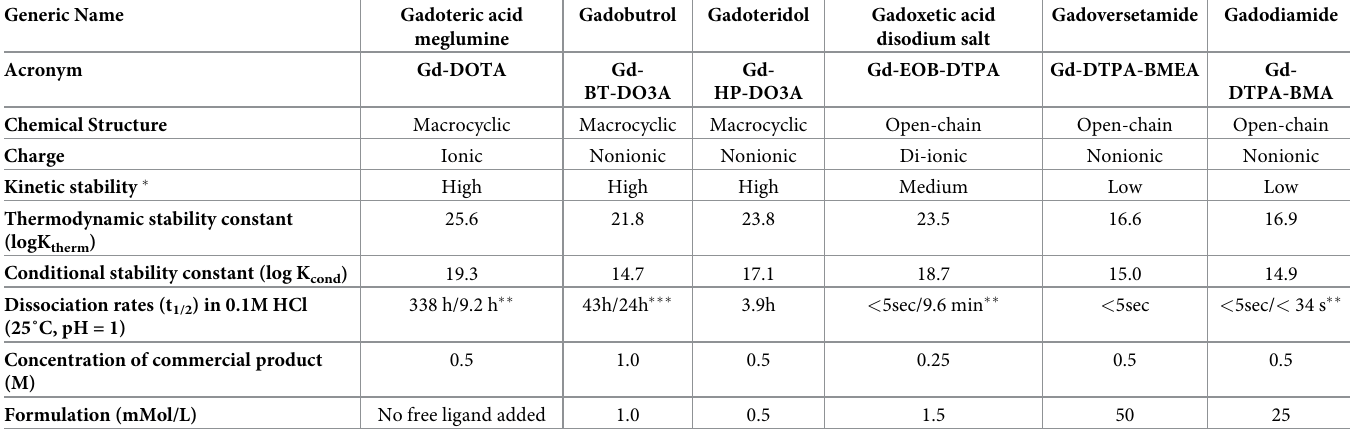
Table 1. Properties of some commercial gadolinium based